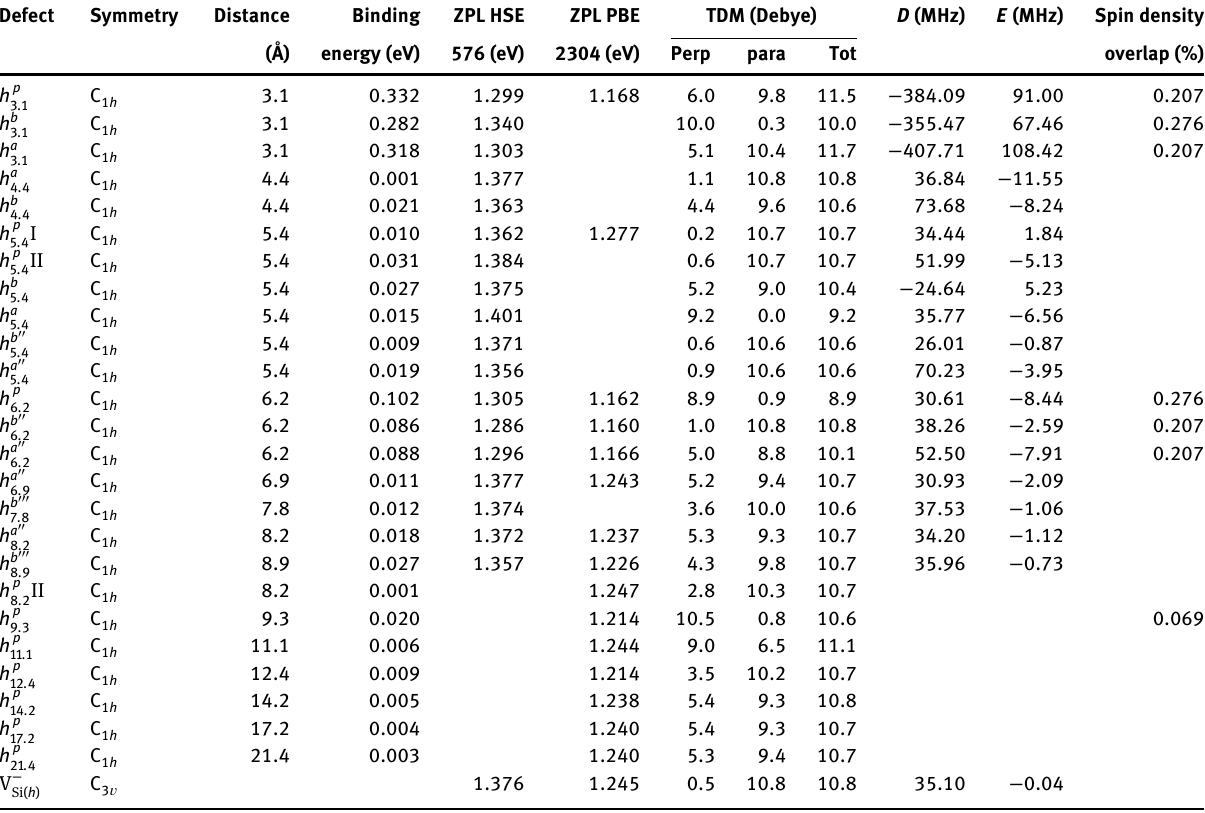
Table 1: The data for all the modified vacancy h configurations. Each configuration is denoted with the symmetry and distance between the silicon vacancy and carbon antisite as well as binding energy. The magneto-optical properties include ZPL (for both 576 atom super cell with the HSE functional and the 2304 super cell with the PBE functional), TDM, D , and E